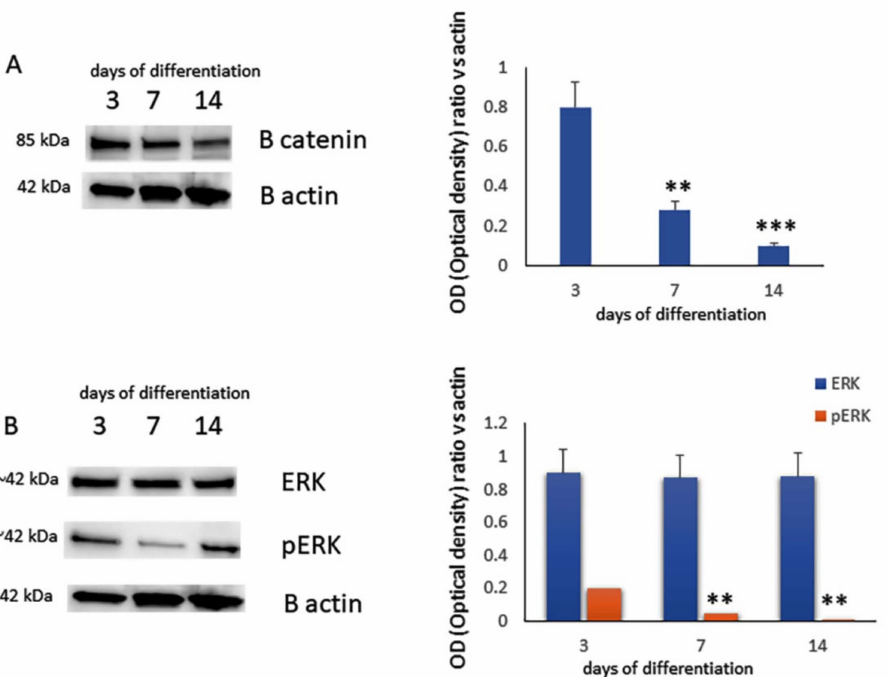
Figure 2. Protein levels assessed by western blot analysis (left side) and quantified as a relative optical density ratio vs. B-actin (right side) of ( A ) B-catenin and ( B ) ERK and pERK on protein lysates from MSCs after 3, 7 and 14 days of chondrogenic differentiation. (** p < 0.005; *** p < 0.001 vs. expression levels of MSCs after 3 days of differentiation).